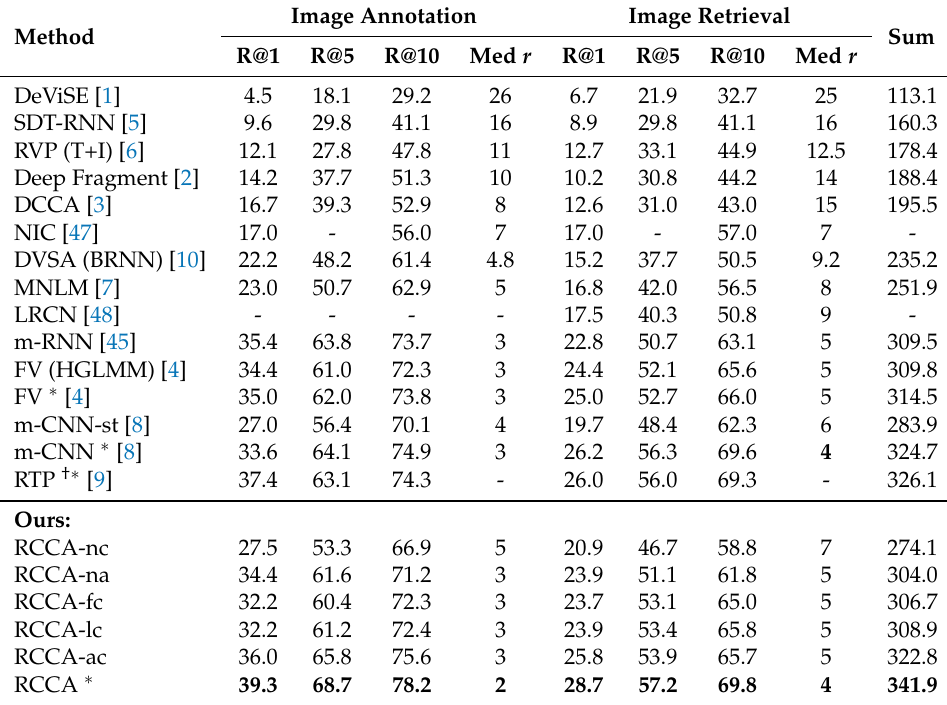
Table 2. Comparison results of image annotation and retrieval on the Flickr30K dataset ( ∗ indicates ensemble or multi-model methods, and † indicates using manual